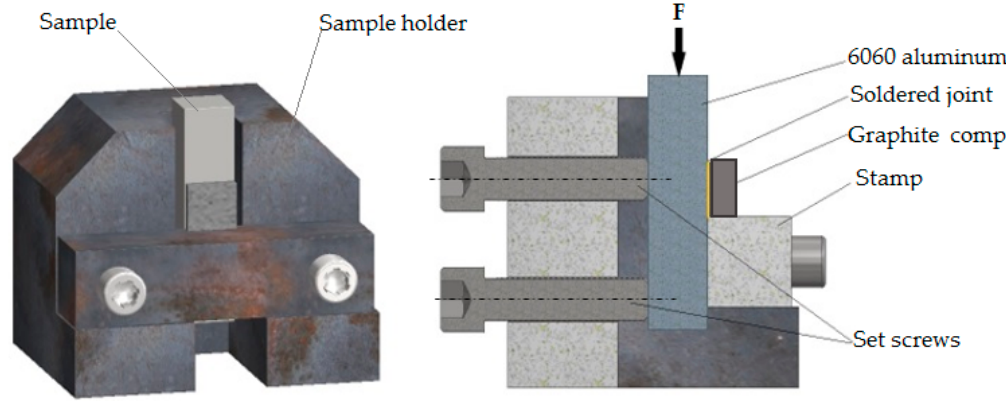
Figure 5. Sample holder used for static shear tests.